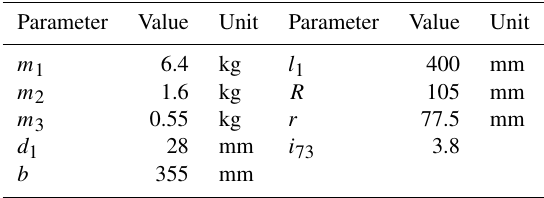
Figure 17. The curves of G 1 ( α ), G 2 ( α ) and Eq. (42) changing with α . Table 1. Structure parameters of the proposed mobile